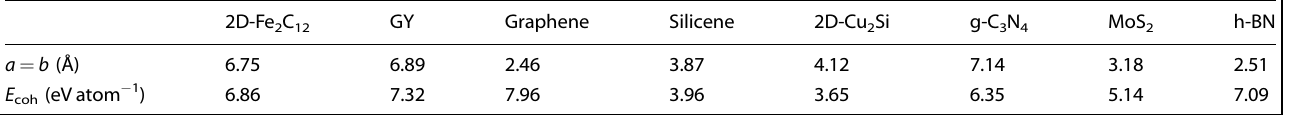
Table 1. Lattice constant ( a = b ) and cohesive energy ( E coh ) of 2D-Fe 2 C 12 and other 2D